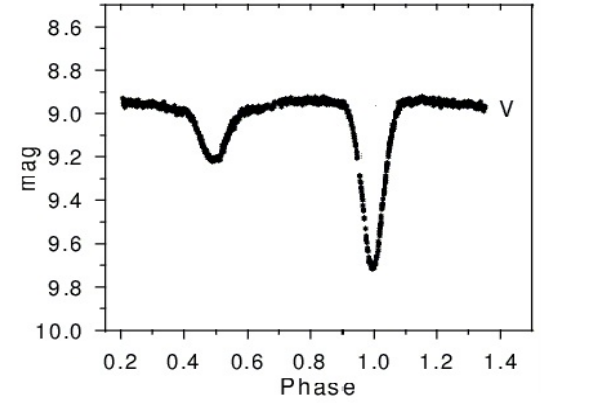
Fig.1: Light curve of RT And.